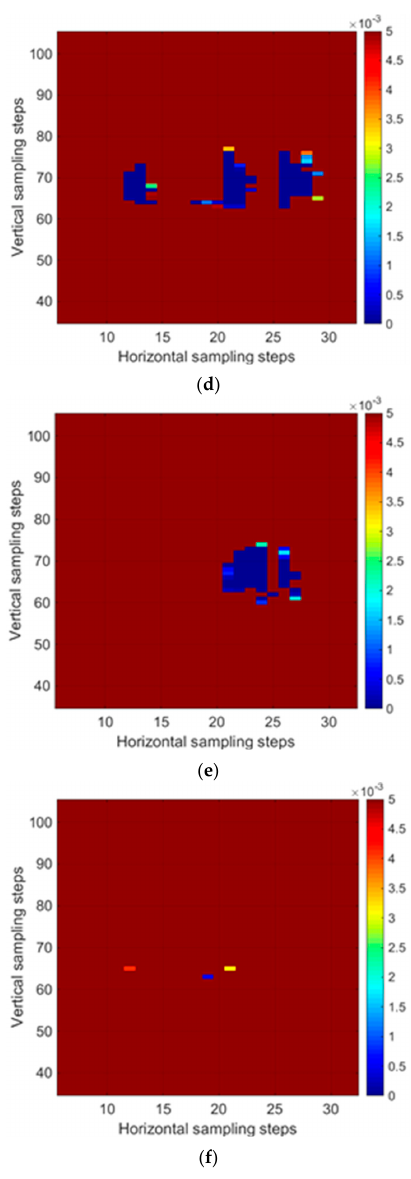
Figure 14. BER matrix during the test times (Test #1) of ( a ) 37, ( b ) 850, ( c ) 1684, ( d ) 1713, ( e ) 1745, and ( f ) 1766 min. 1766